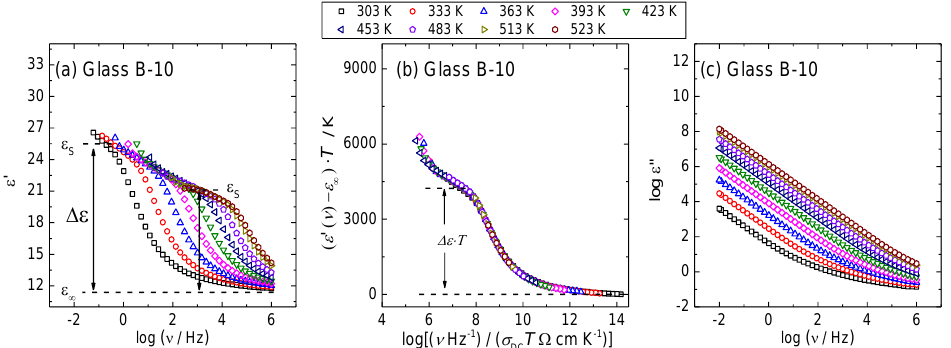
Figure 7. ( a ) Real permittivity spectra at different temperatures, ( b ) their scaled representation obtained using Summerfield scaling procedure and ( c ) imaginary permittivity spectra at different temperatures for glass B-10.